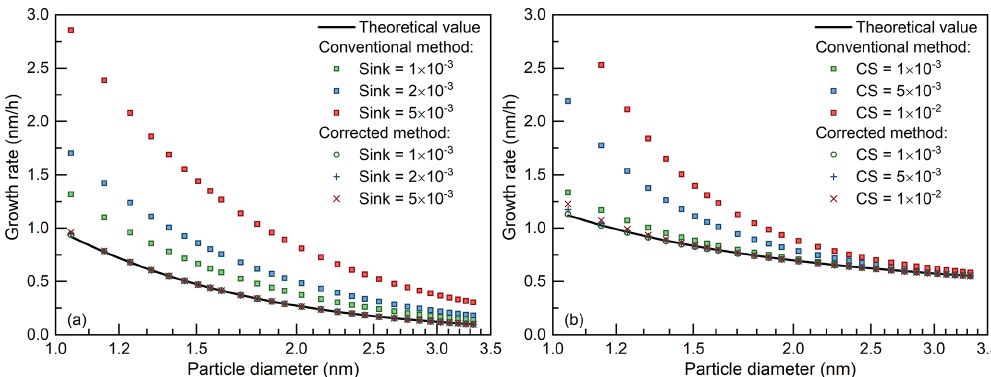
Figure 3. The impact of sinks for the appearance time method and its correction. The theoretical curve is obtained using the condensation rate of the condensing vapor (Eq. 1) and the scatterplots are obtained using the conventional and corrected appearance time method. The sink is assumed to be independent of and dependent on particle diameter in (a) and (b) , respectively. The scatterplots for the corrected method lie on top of each other. The size-dependent coagulation sink in (b) was estimated from the condensation sink (CS) shown in the legend using an empirical formula (Lehtinen et al., 2007). The coagulation sink is taken as the input value of the model; hence, the validity of the empirical formula does not affect the accuracy of simulated size distribution or the growth rate. The minor discrepancy among the corrected growth rates comes from the size-dependent particle coagulation coefficient and coagulation sink.